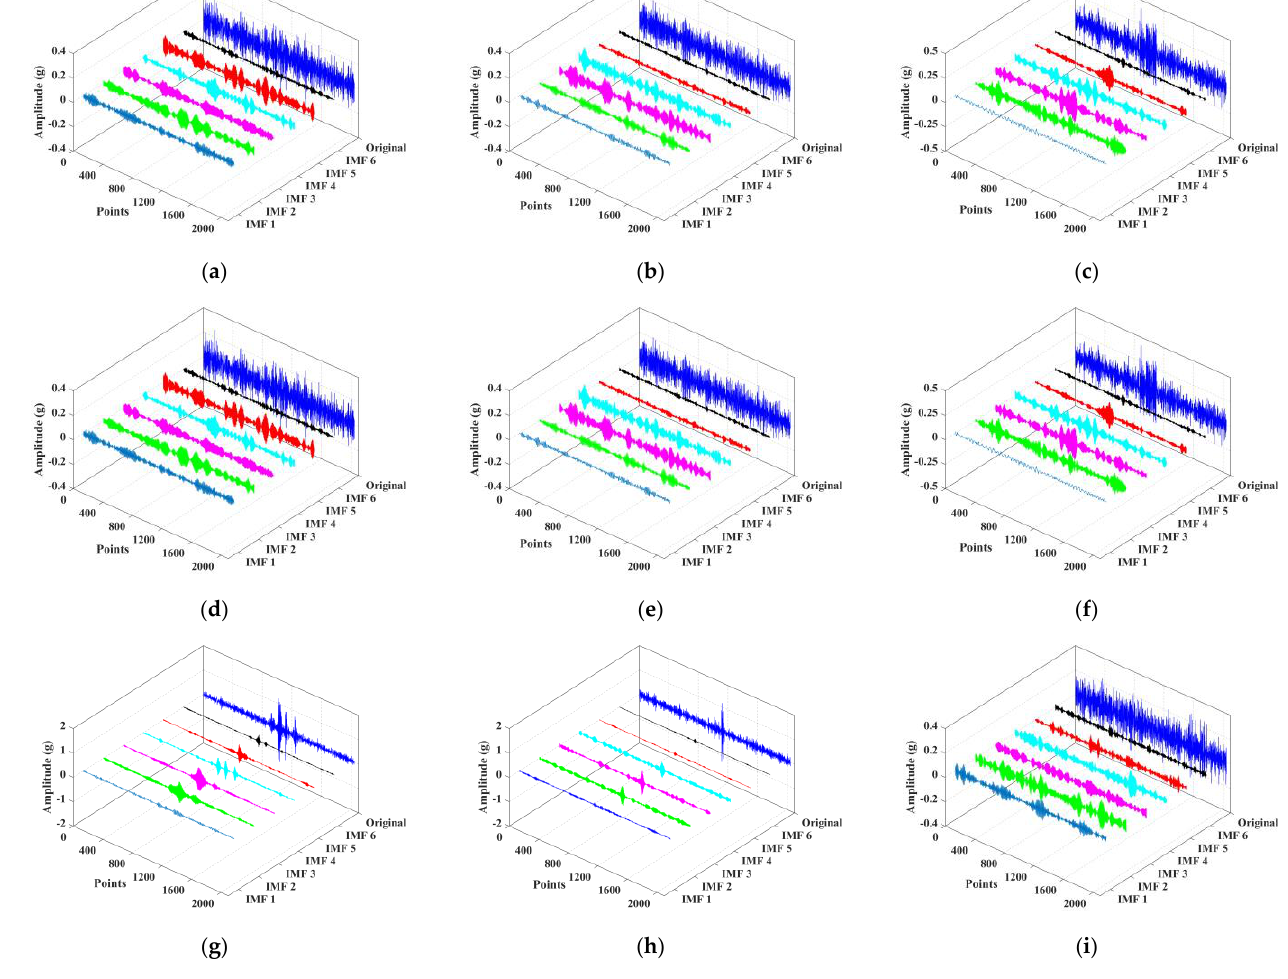
Figure 10. The VMD decomposition results of each fault type signal: ( a ) outer race 0.2 mm crack; ( b ) outer race 0.4 mm crack; ( c ) outer race 0.4 mm crack; ( d ) inner race 0.2 mm wear; ( e ) inner race 0.4 mm wear; ( f ) inner race 0.6 mm wear; ( g ) rolling element 0.2 mm wear; ( h ) rolling element 0.4 mm wear; ( i ) rolling element 0.6 mm wear.